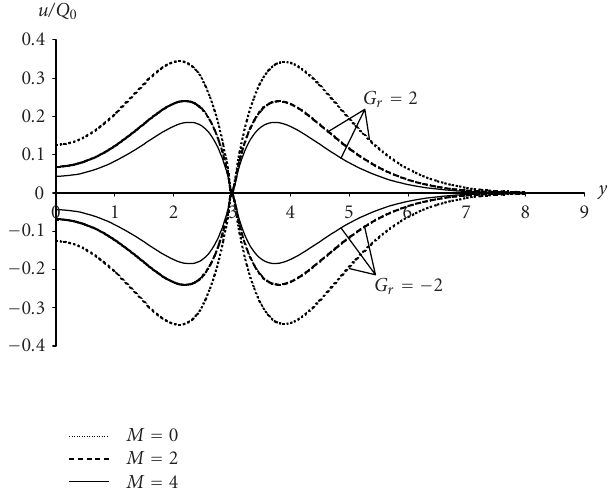
Figure 7.8. The velocity distribution for di ff erent values of M for the semispace problem.